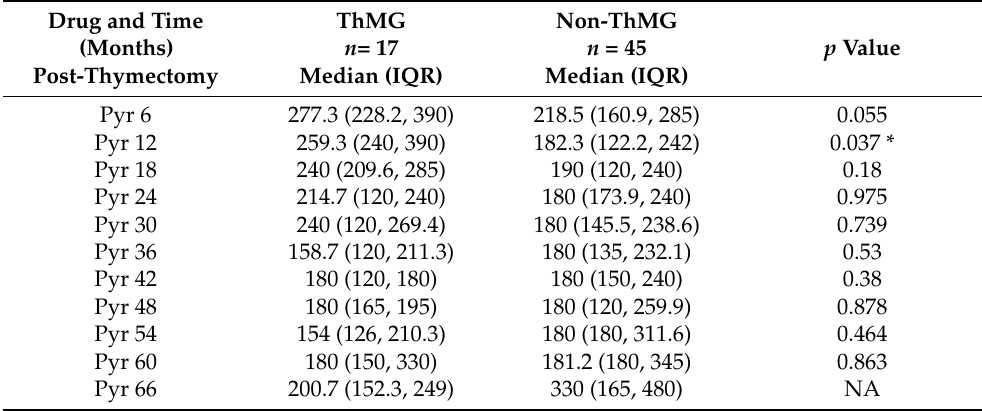
Table 3. Comparison of time-weighted averages (TWAs) of pyridostigmine (Pyr) dosage requirements (mg/d) after thymectomy between ThMG and non-ThMG patients.